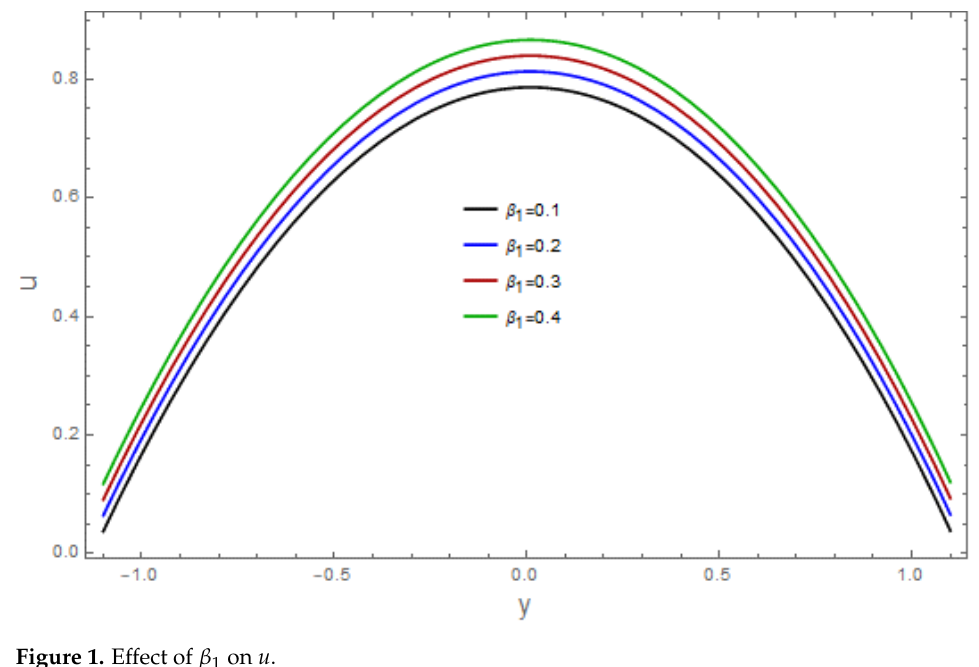
Figure 1. Effect of 𝛽₁ on 𝑢 .